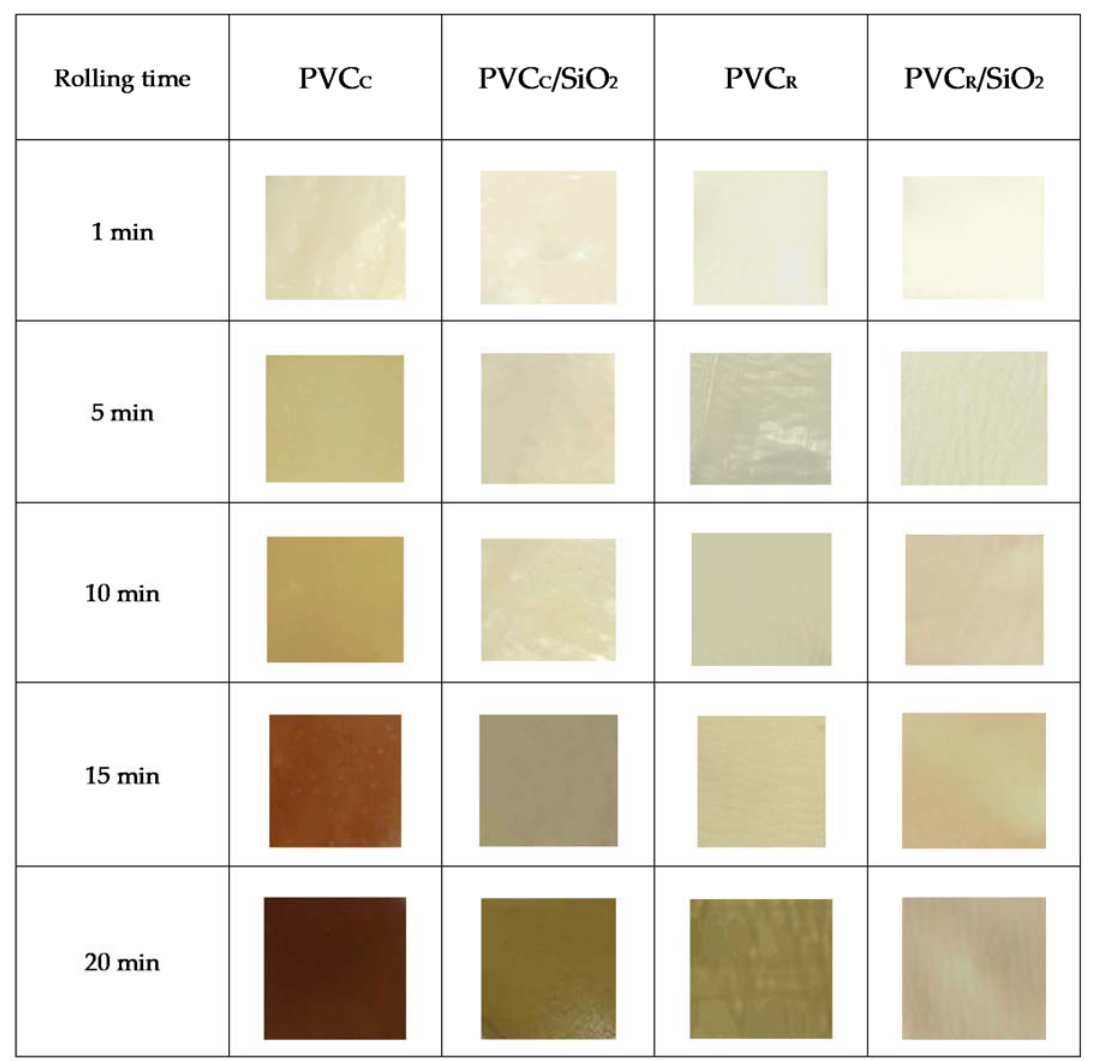
Figure 3. Color changes of PVC C and PVC R samples and PVC composites with SiO 2 as a function of the time of rolling progress.